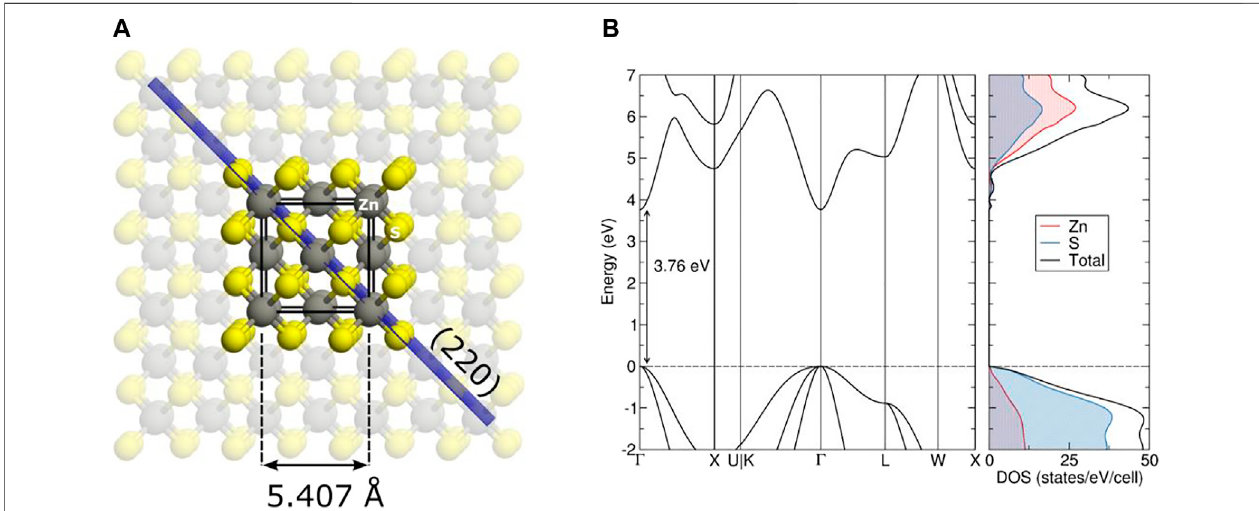
FIGURE 7 | Crystal structure of bulk ZnS sphalerite shown on the (A) . The unit cell is indicated with black lines, the (220) crystallographic plane with the blue coloured plane, while zinc and sulphur atoms are coloured grey and yellow, respectively. On the (B) , the electronic band structure together with the atom-projected densities of state are shown. The dashed line indicates the highest occupied